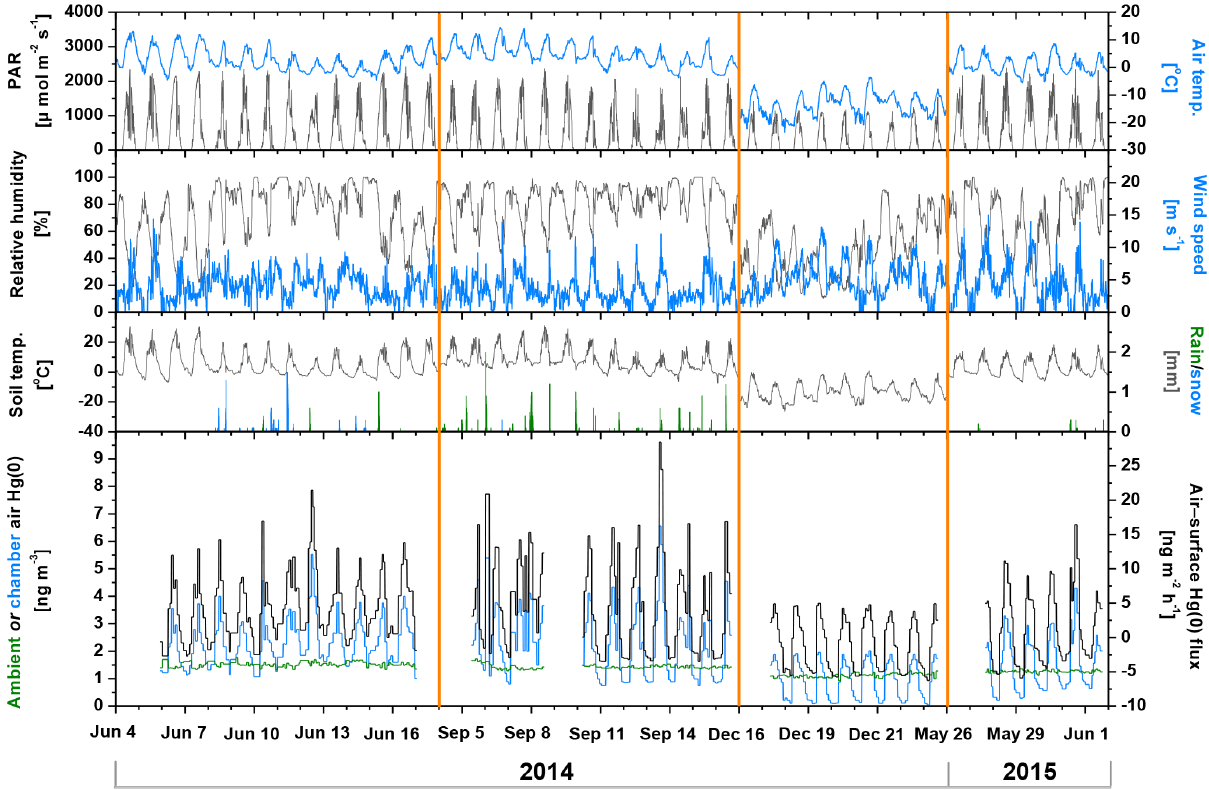
Figure 2. Temporal variation in environmental variables, air Hg(0) concentrations inside and outside of the chamber, and air–surface Hg(0) flux at the Beiluhe station in the central QTP during four campaigns in